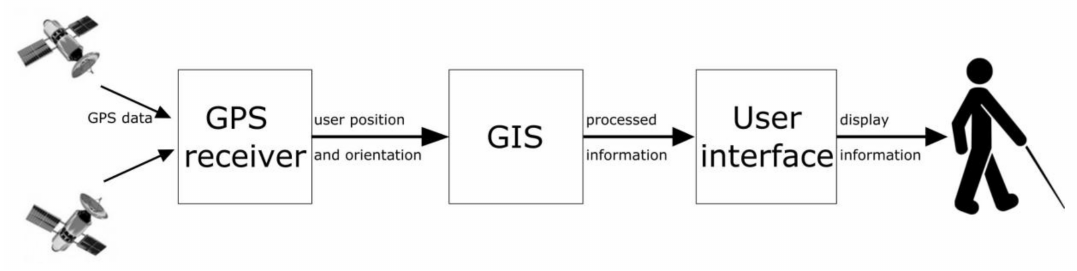
Figure 1. Functional modules of a global positioning system (GPS)-based navigation assistive